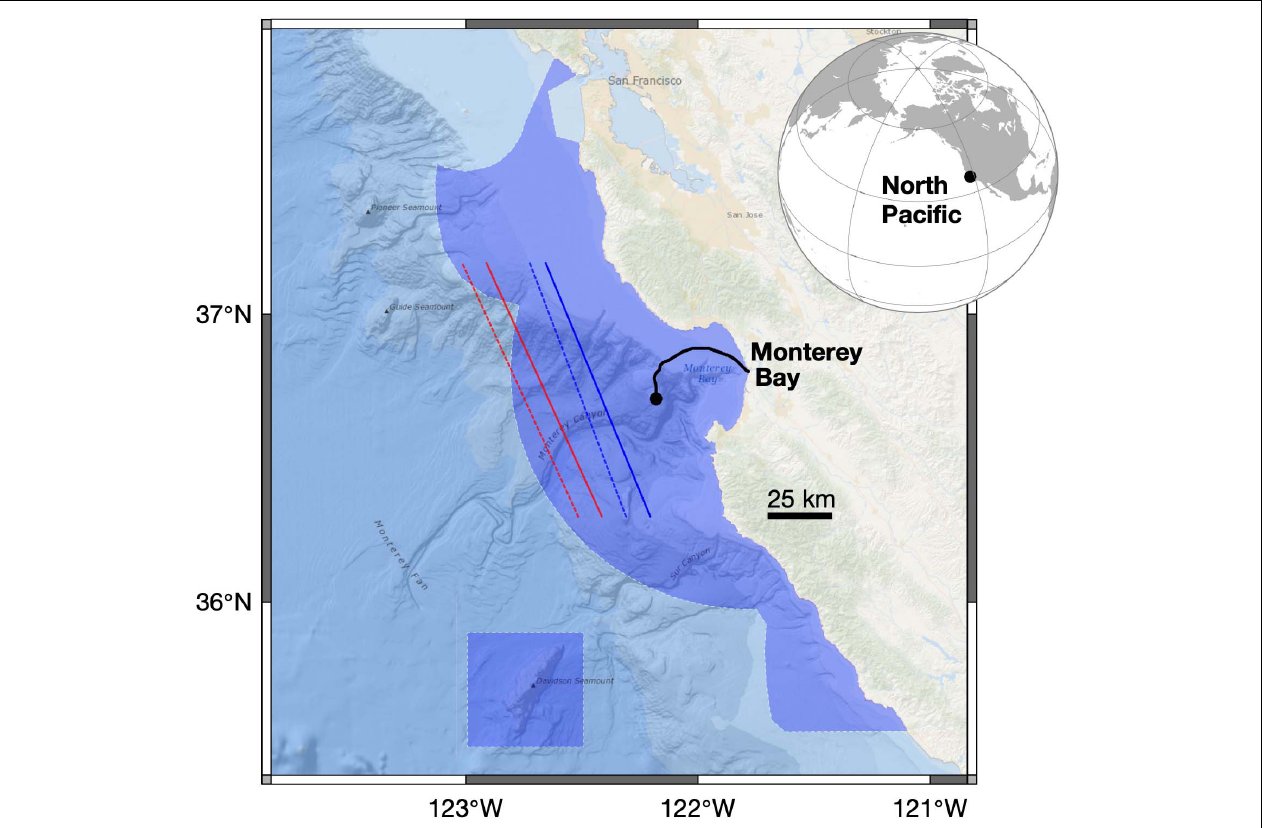
FIGURE 1 | The study region along the eastern margin of the North Pacific. Blue shaded regions define the Monterey Bay National Marine Sanctuary, which includes a region adjacent to the California coast centered on Monterey Bay and an offshore region around Davidson Seamount. The hydrophone is connected to the Monterey Accelerated Research System (MARS) cabled observatory (black line and circle; main node at 36.713 ◦ N, 122.186 ◦ W, 891 m depth). Blue and red lines define recommended tracks for northbound (solid) and southbound (dashed) shipping traffic for vessels 300 gross tons and above; red lines are for vessels carrying hazardous cargo in bulk or crude